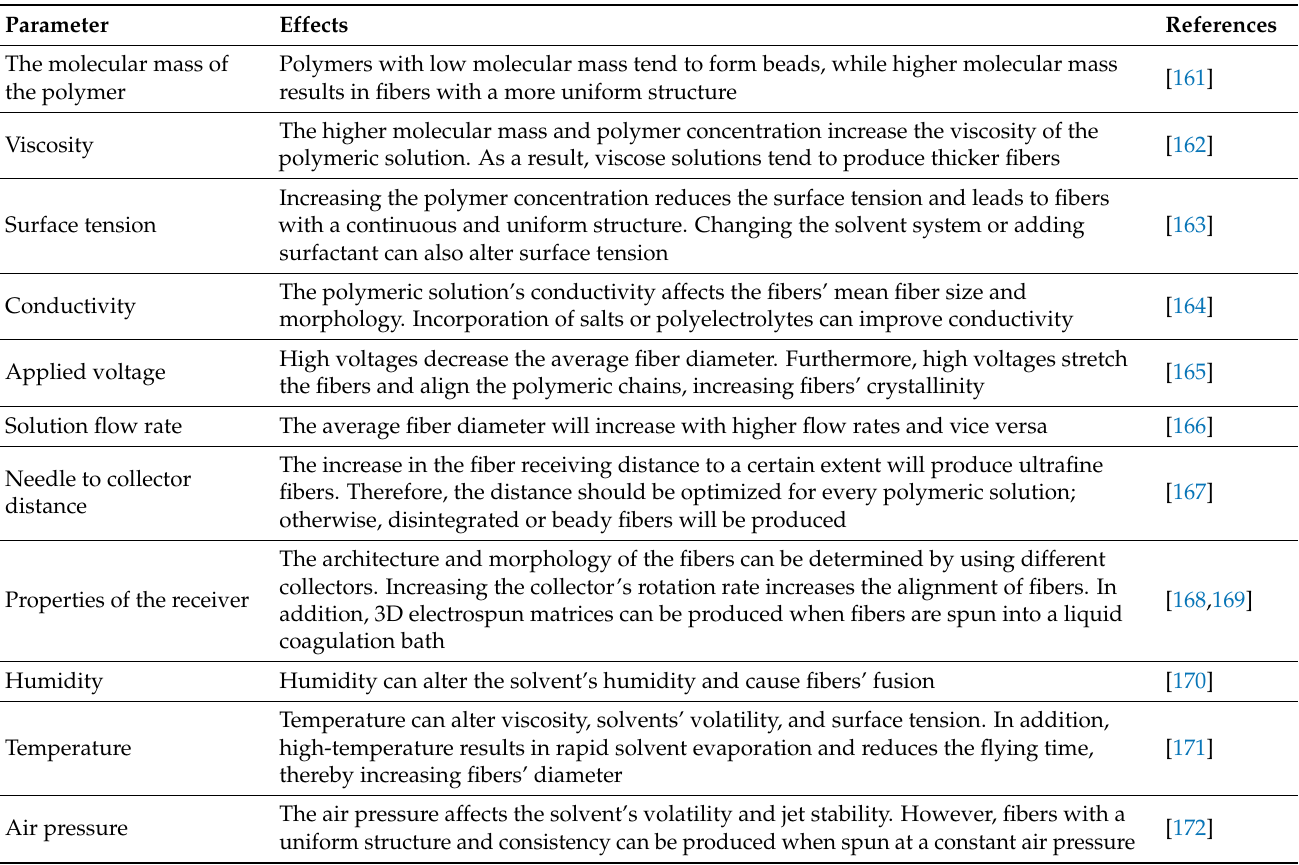
Table 2. Parameters affecting the properties of electrospun